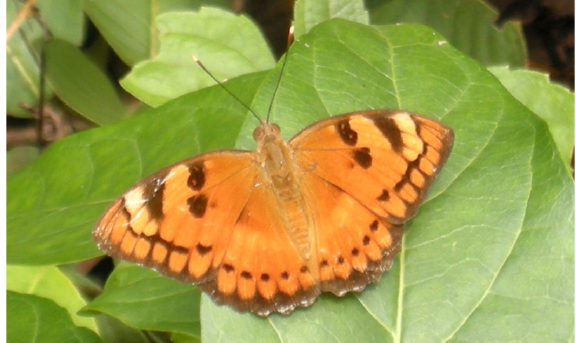
Image 9. Baronet Symphaedra nais